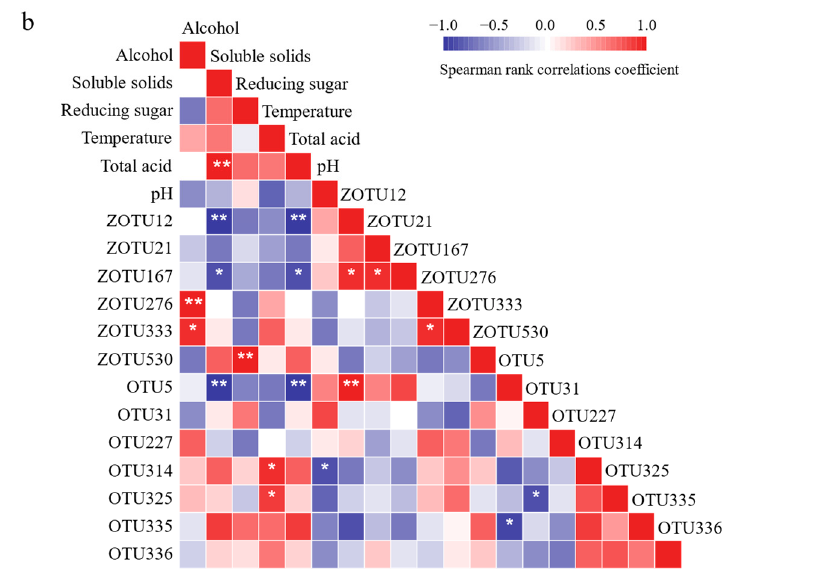
Figure 1. ( a ) Dynamic changes in physicochemical parameters during fermentation of ZJV. Temperature, pH, reducing sugar content, alcohol content, soluble solids and total acidity. ( b ) Heat map of physicochemical indicators and microbial correlation. * and ** mean significance at the 0.05 and 0.01 probability levels respectively.